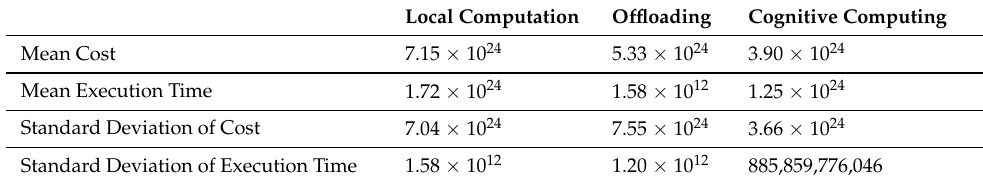
Table 2. Significance of results.